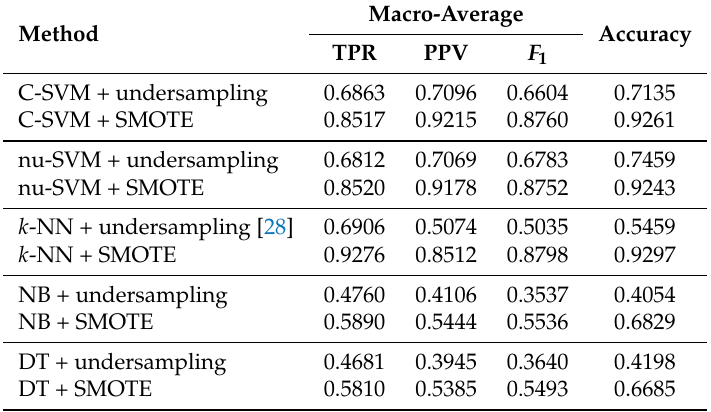
Table 7. Average performance comparisons of five benchmark methods over five-fold cross